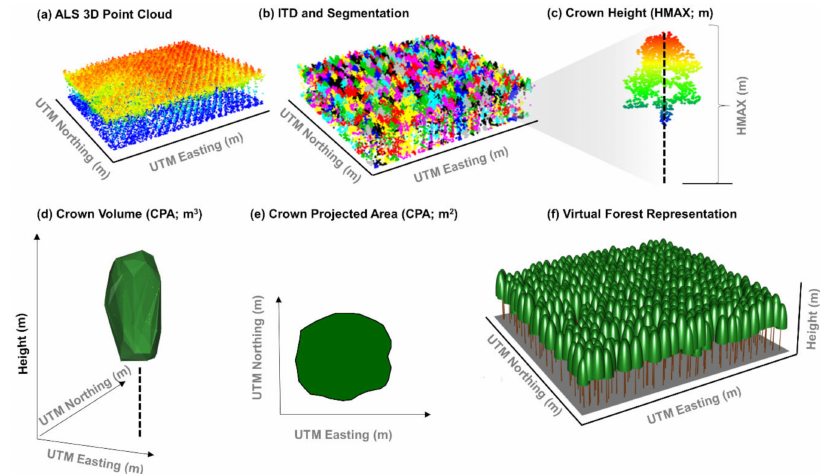
Figure 2. Individual tree metrics computation. ( a ) Airborne lidar (ALS) 3D point cloud; ( b ) 3D point cloud colored by individual tree after detection and delineation; ( c ) crown height computation; ( d ) crown volume (CV; m 3 ); ( e ) crown projected area (CPA; m 2 ); and ( f ) virtual forest